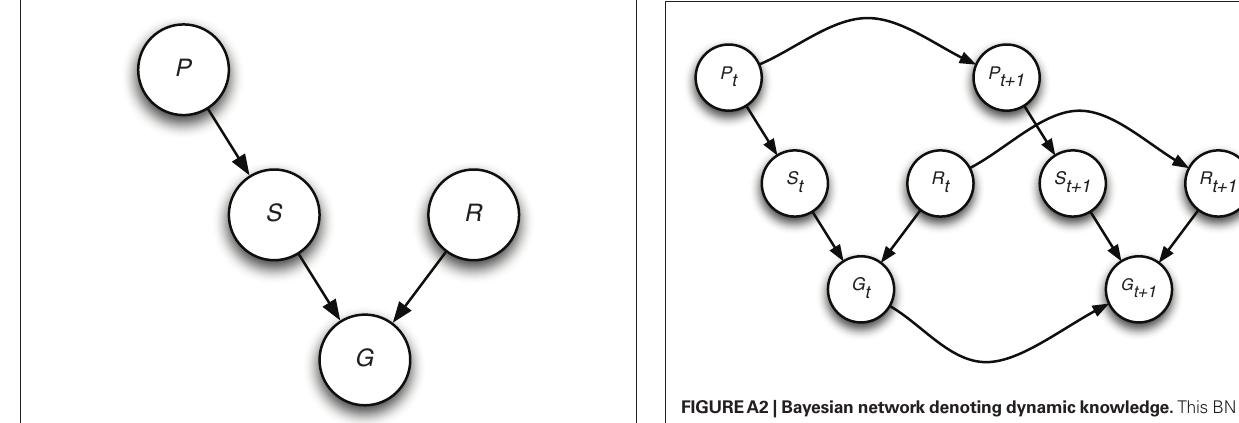
Figure A2 | Bayesian network denoting dynamic knowledge. This BN contains four variables: P , S , R , and G . These variables exist multiple times, once each time slice. As in Figure 1 their dependencies are denoted by arcs, but in addition there are also dependencies between various variables in different time slices: P depends on P , etcetera. However, S is t + 1 t t + 1 independent of S in t